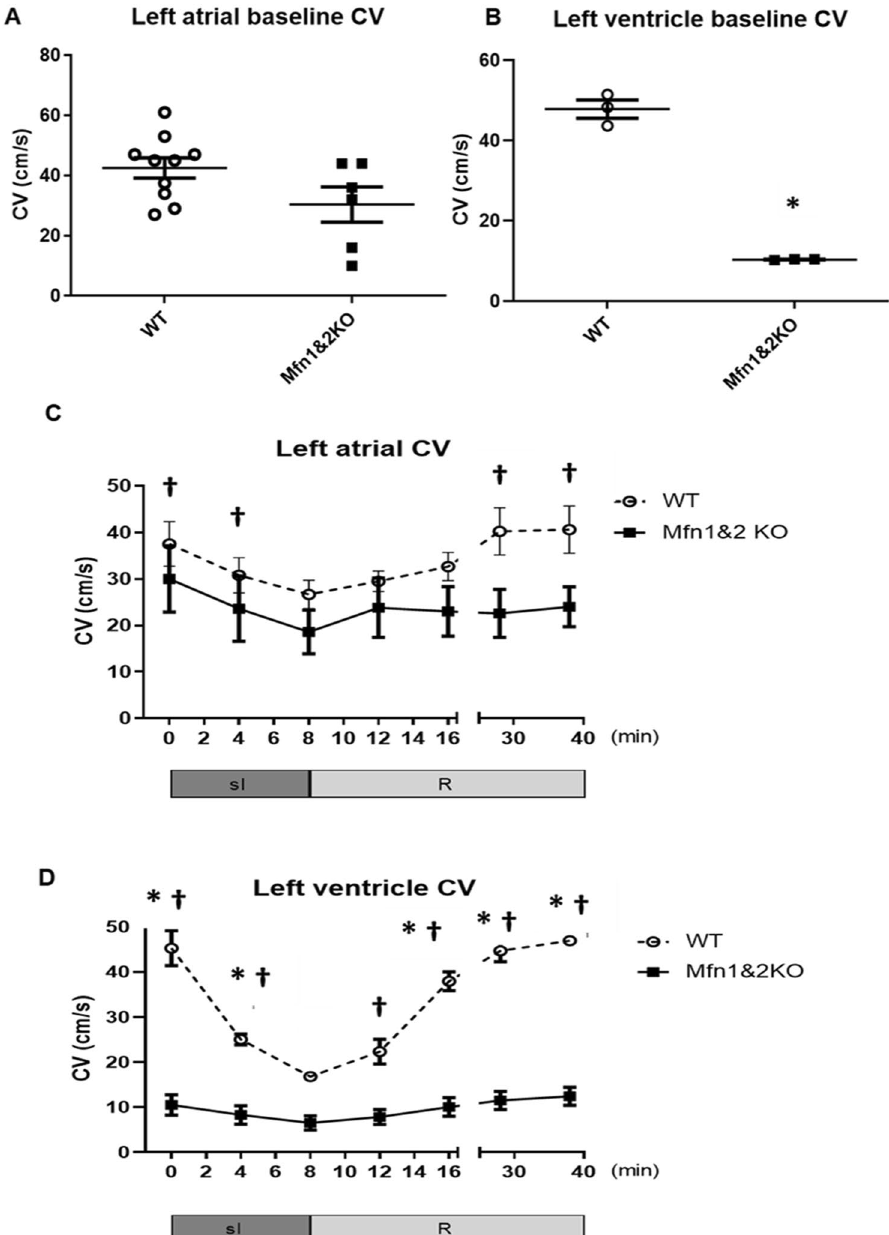
Figure 3. Conduction velocities (CV) of the atrial and ventricular tissue. Baseline CV of the ( A ) left atrial and ( B ) left ventricle of the wild-type (WT) versus Mfn-DKO hearts, *p < 0.05 when compared against WT. Changes in the CV during simulated ischemia (sI) and reperfusion (R) of the ( C ) left atrial tissue and ( D ) left ventricular tissue of the WT versus Mfn-DKO hearts, *p < 0.05 when compared against DKO; † p < 0.05 when compared against the lowest CV at the end of ischemia. Data are presented as mean ±